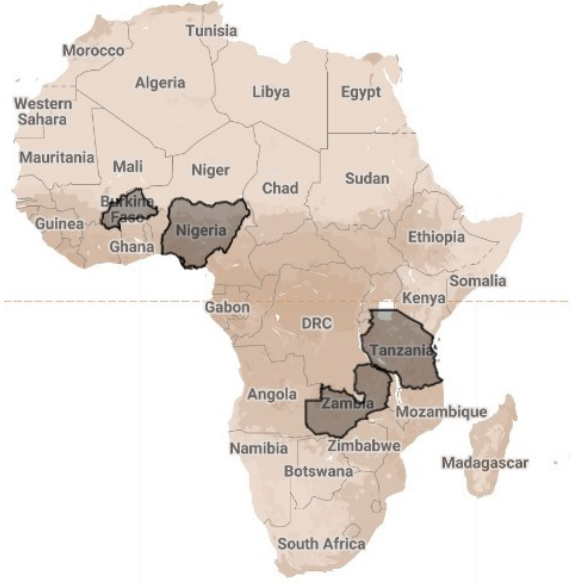
Figure 1. Country selection for assessment [14].